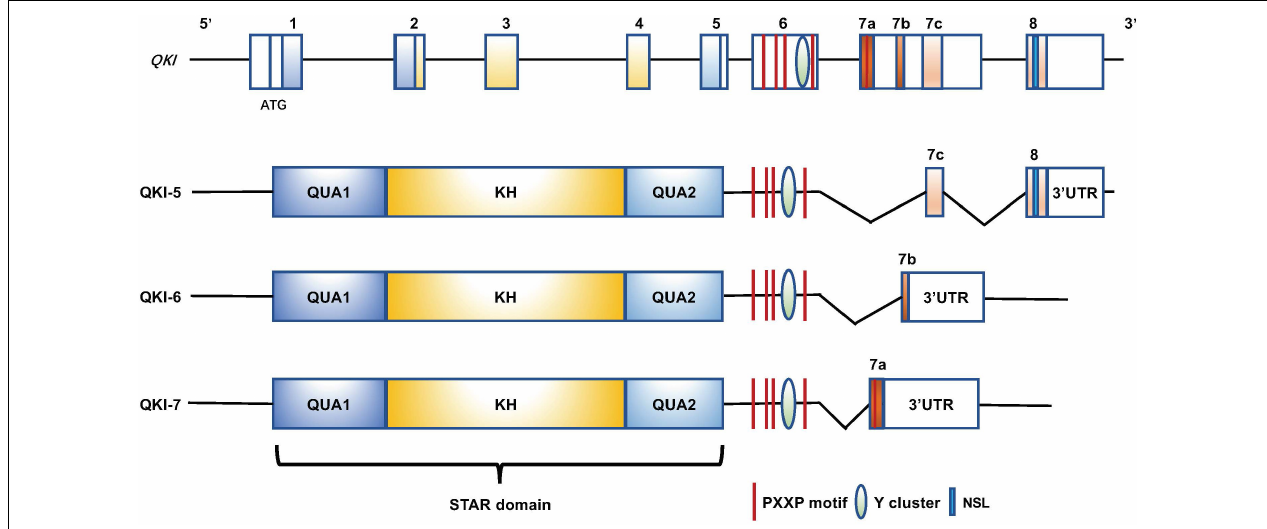
FIGURE 1 | Genomic and protein domain structure of the human QKI gene and QKI isoforms (QKI-5, QKI-6, and QKI-7). All isoforms contain an RNA-binding motif (KH domain) that is flanked by QUA1 and QUA2 domains. The proline-rich PXXP motifs and the tyrosine cluster are at the C-terminus, and they exhibit distinct C-terminal structures resulting from alternative splicing of QKI primary transcripts. QKI-5 has a nuclear localization signal (NLS) at the